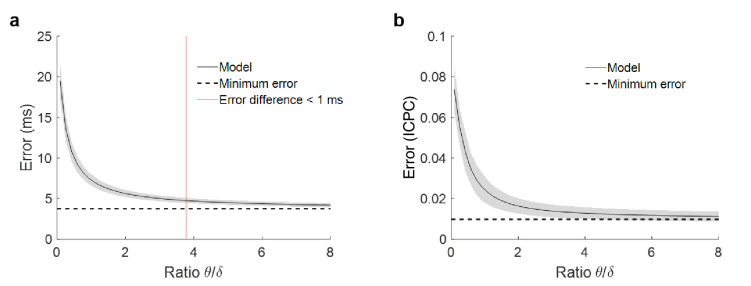
Error in phase estimation in function of theta power.(a) Phase estimation error for simulations with different ratio between theta and delta power. Each point of the solid black line represents the mean error and the grey shadow the standard deviation over 100 simulations. The dashed line is the minimum error, when no noise is added to the model and the estimation does not depend on theta power. The red line marks the point where error due to power is lower than one millisecond (ratio = 3.78). (b) Estimation of the error in the ICPC between two signals as a function of the ratio between theta and delta, following the same methodology as in panel (a) to simulate the signals. For a ratio of 3.78, the accuracy of the ICPC value has and error lower than ±0.01.